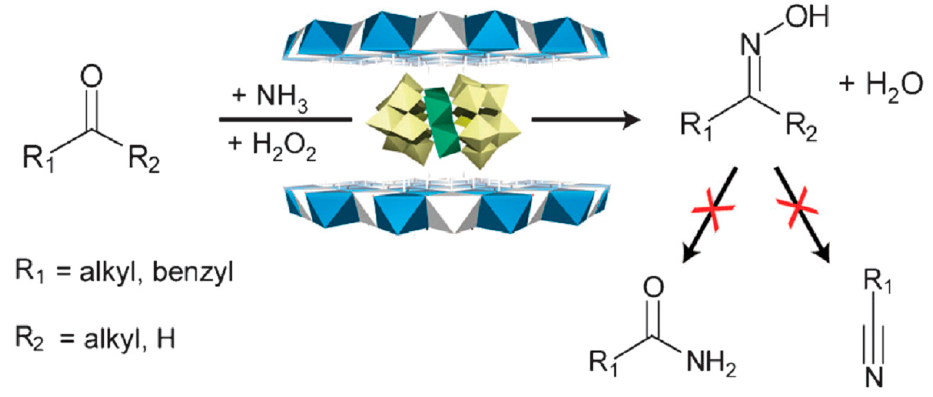
Figure 12. Schematic of the synergistic effect of LDH-POM catalysts for promotion oximation of aromatic aldehydes [7]. Adapted from Ref. [12], Copyright 2014, Elsevier.